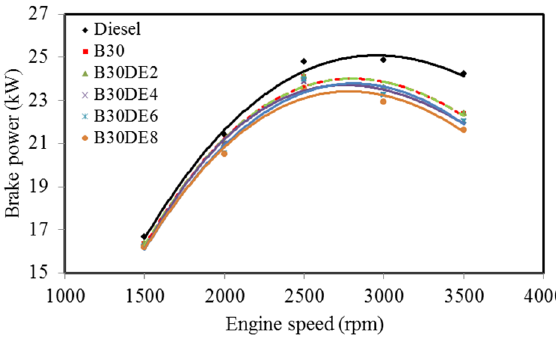
Figure 8. Variation of engine brake power for different diethyl ether additive ratios.